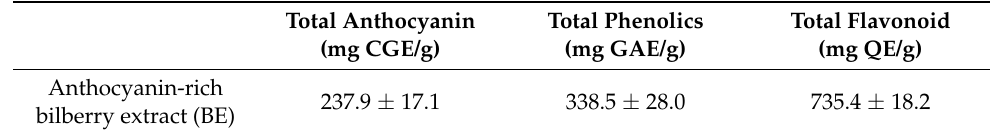
Table 3. Polyphenol contents in